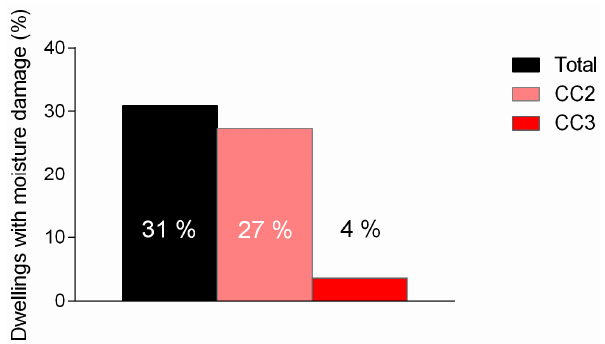
Figure 1. Percentage of Norwegian dwellings with different levels of moisture damage (CC2 or CC3). CC2: structural elements have clearly signs of damage, excessive wear or have poor functionality; there is a need for remediation/the building component is estimated to have a short remaining life. CC3: substantial wear and damage/total malfunction, requiring urgent action.